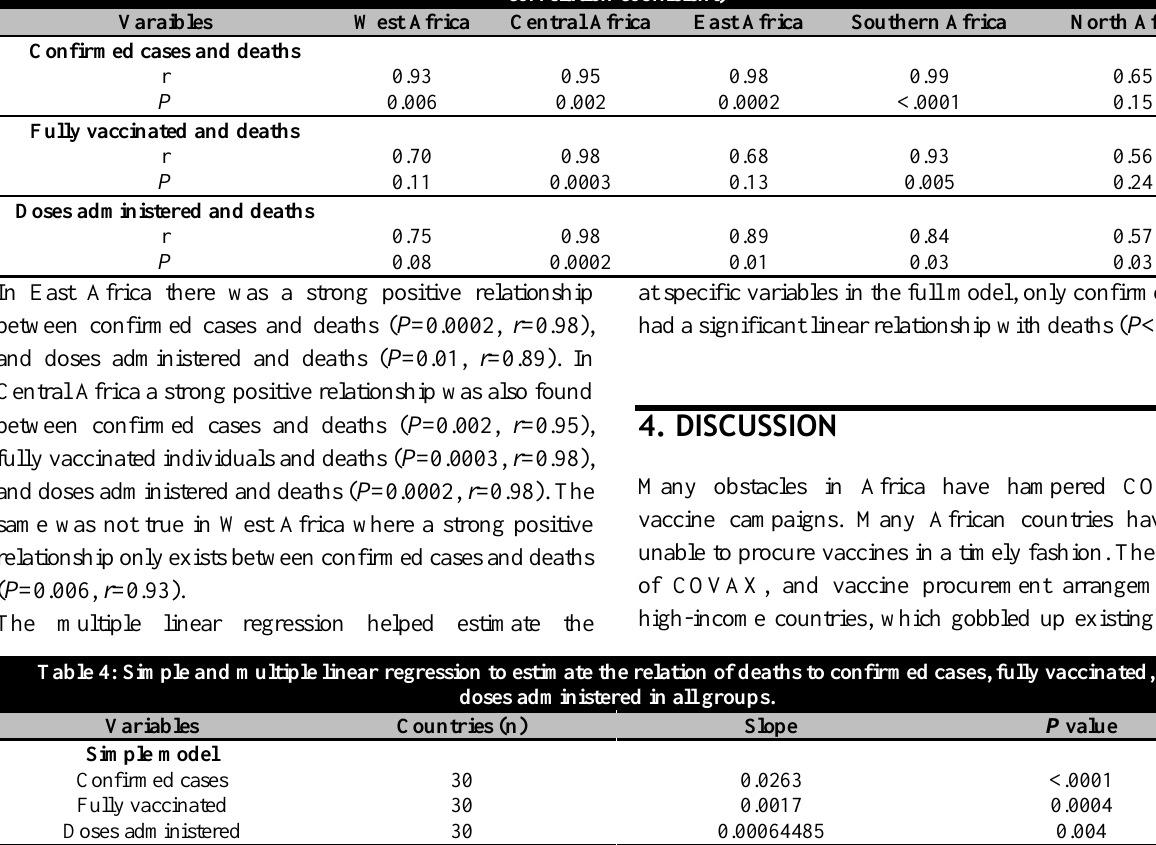
Table 3: Correlation test to evaluate the existence of a relationship between the total number of deaths and total number of confirmed cases, total number of fully vaccinated individuals, and total doses of vaccine administered in the five regions (r =